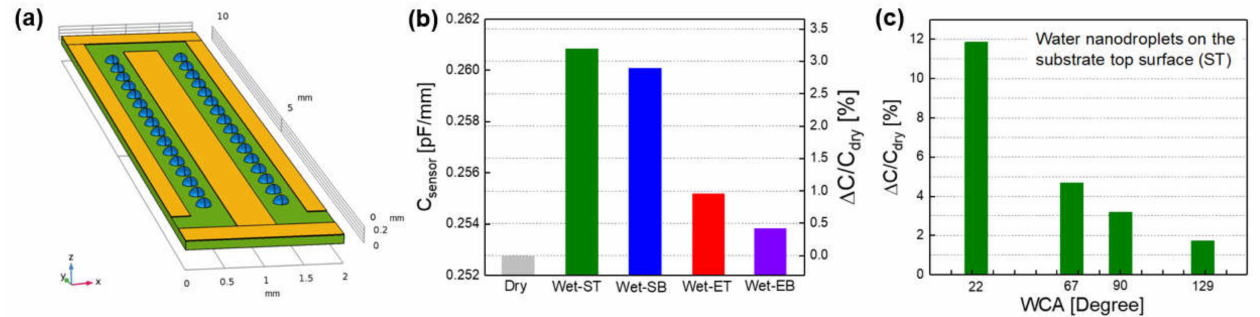
Figure 7. FEM simulation results on the increase in sensor capacitance (C sensor ) according to location and contact angle of 32 water nanodroplets: ( a ) a schematic of unit capacitive sensor with the nanodroplets (blue color) between IDE finger electrodes (yellow color) on PET substrate (green color), ( b ) the increase in C sensor according to the formation and location of the nanodroplets with the WCA of 90 ◦ , and ( c ) the increase in C sensor with the change in WCA of the nanodroplets on the substrate top surface.